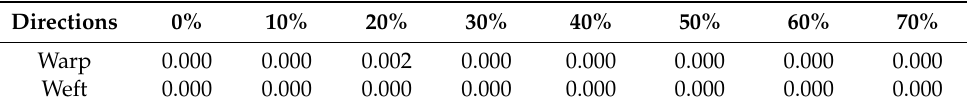
Table 3. The p values of significances among samples 2 × 2, 2 × 4, 2 × 6 and 2 × 8 under different water absorption